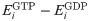
Energetic contributions of residues.Difference between overall residual contributions per MT ring in GTP- and GDP-Model; (EiGTP−EiGDP), where i is the residue number running from 1 to 1742. Different energy axes are used due to differences in magnitude of interactions at both interfaces. Important residues are labeled together with their domains.